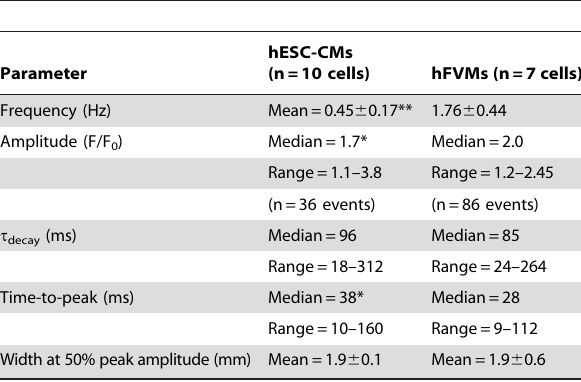
Table 2. Ca 2 + spark parameters in hESC-derived and fetal ventricular cardiomyocytes.